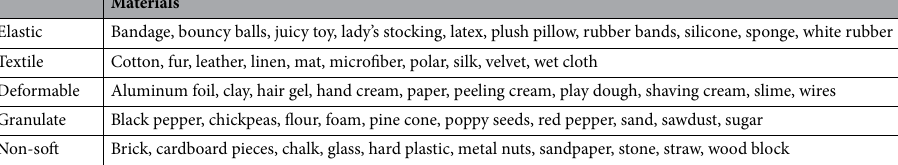
Table 3. Materials that were used in the experiment, organized by salient material